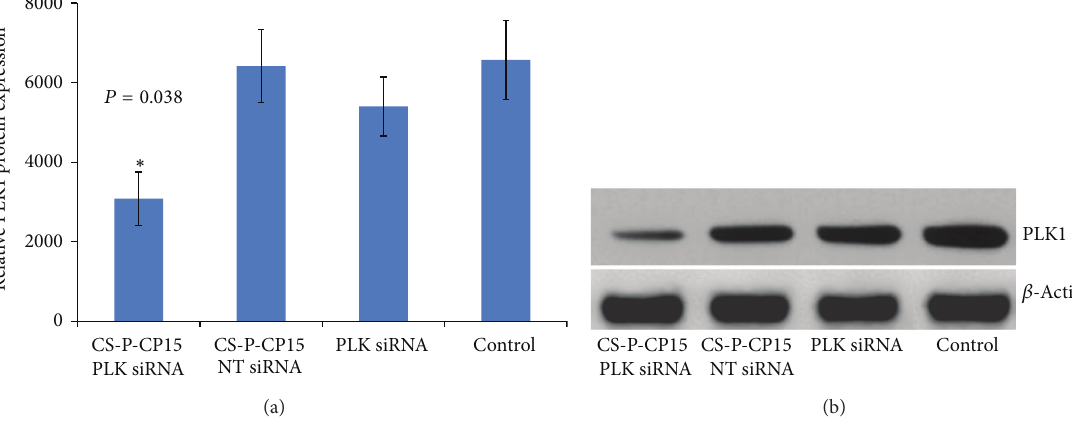
Figure 6: Western blot analysis from 100 𝜇 g of total protein extracted from tumor tissues of colon cancer. The PLK1 protein expression was compared among different groups after normalizing the 𝛽 -actin levels among all the animals. The graph (a) represents relative protein expression of PLK1 gene in tumor tissue after intraperitoneal administration of various treatment formulations; (1) CS-PEG-CP15 with siRNA against PLK1 gene, (2) CS-PEG-CP15 with non-targeting biotin-siRNA, (3) PLK1 siRNA alone, and (4) untreated control: saline. Reduction in PLK1 protein expression was observed with treatment formulation (1) as compared with untreated and mock transfection controls. The graph shows a representative result of 𝑛 = 6 in each group, mean ± SE. ∗ 𝑃 < 0.05 was considered significant based on Tukey’s post hoc analysis, when compared with other groups.